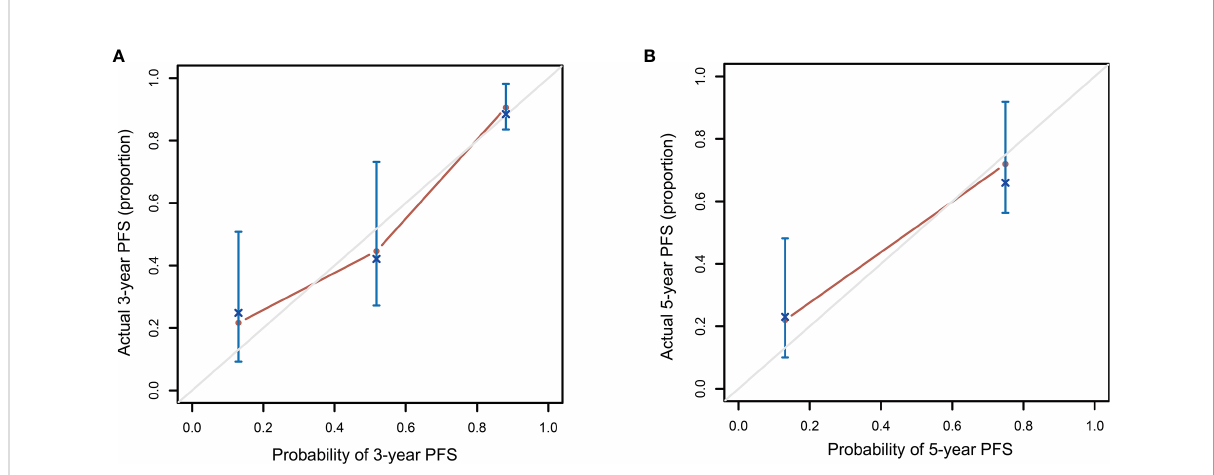
FIGURE 4 Calibration plot comparing the observed and predicted progression-free survival probabilities at 3 (A) and 5 (B)